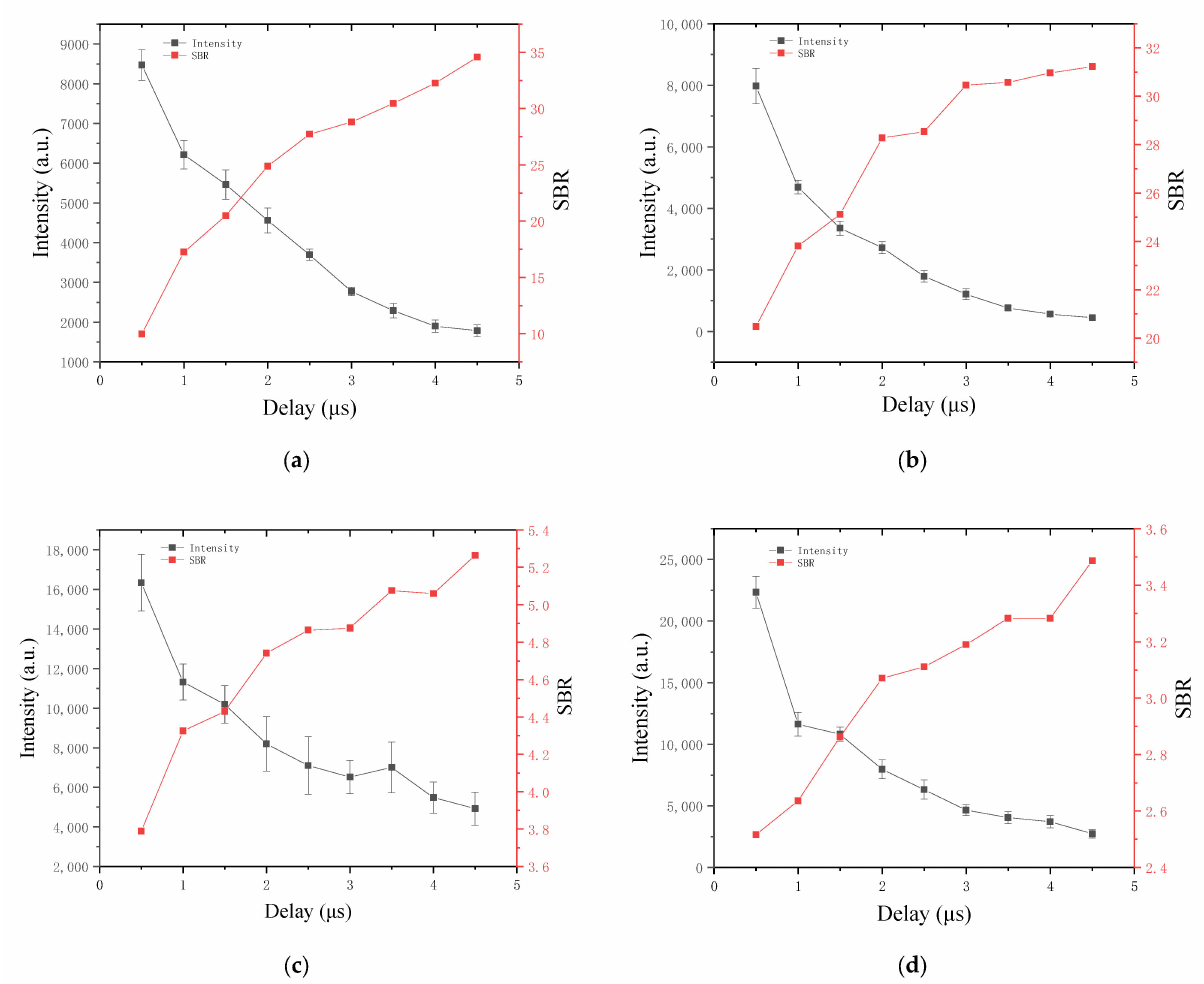
Figure 5. Optimization of ICCD delay time on the emission of ( a ) Cr; ( b ) Cu; ( c ) Pb; ( d )